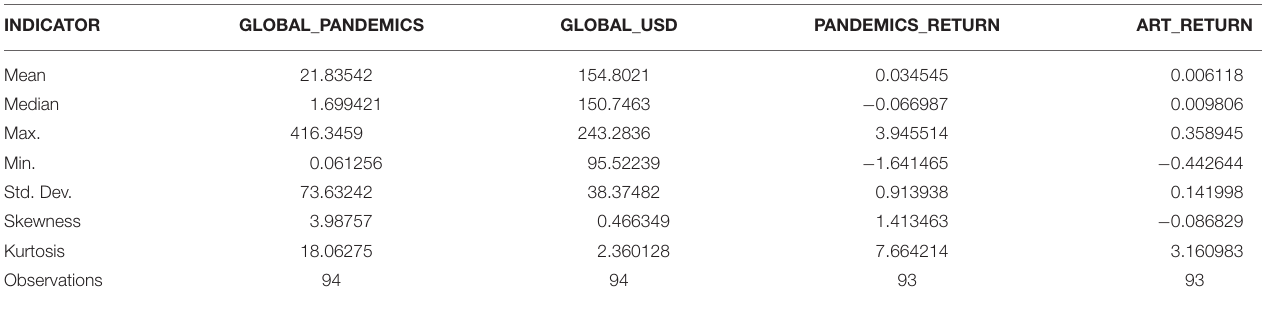
TABLE 1 | Descriptive summary statistics